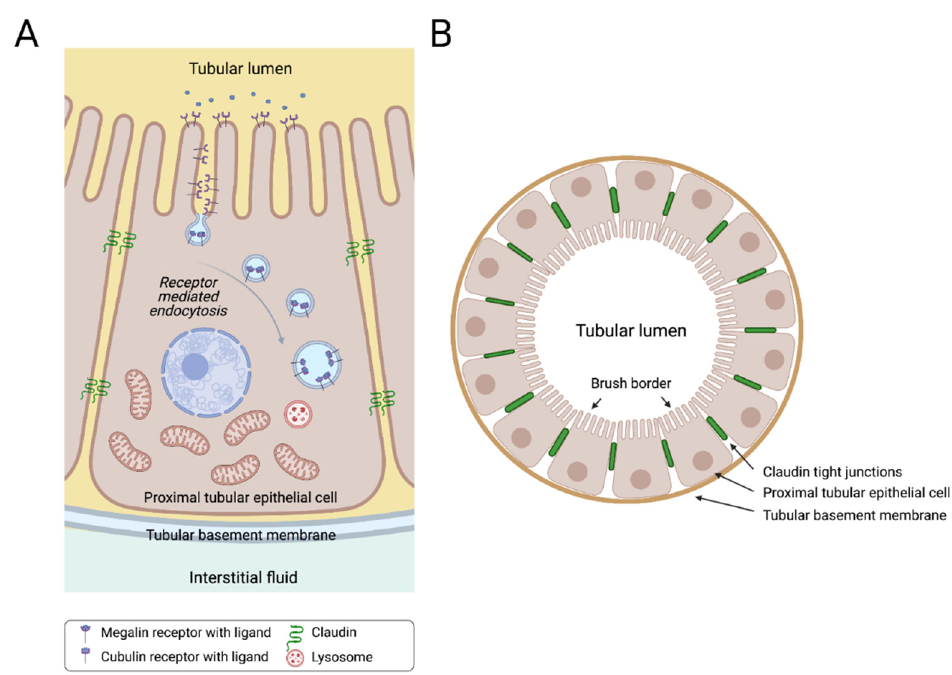
Figure 2. Sagittal ( A ) and cross ( B ) sections of a human proximal tubule. Proximal tubular epithelial cells (PTECs) are indispensable cells for the nephron tubular system. PTECs are highly metabolically active cells that are responsible for reabsorbing many of the filtered solutes in the proximal part of the nephron. These cells are typically characterized by a brush border at the apical side, and high numbers of mitochondria at the basal side of the cell. Megalin and cubulin are characteristic multi-ligand receptors for PTECS, located at the brush border, responsible for receptor-mediated endocytosis for various ligands.